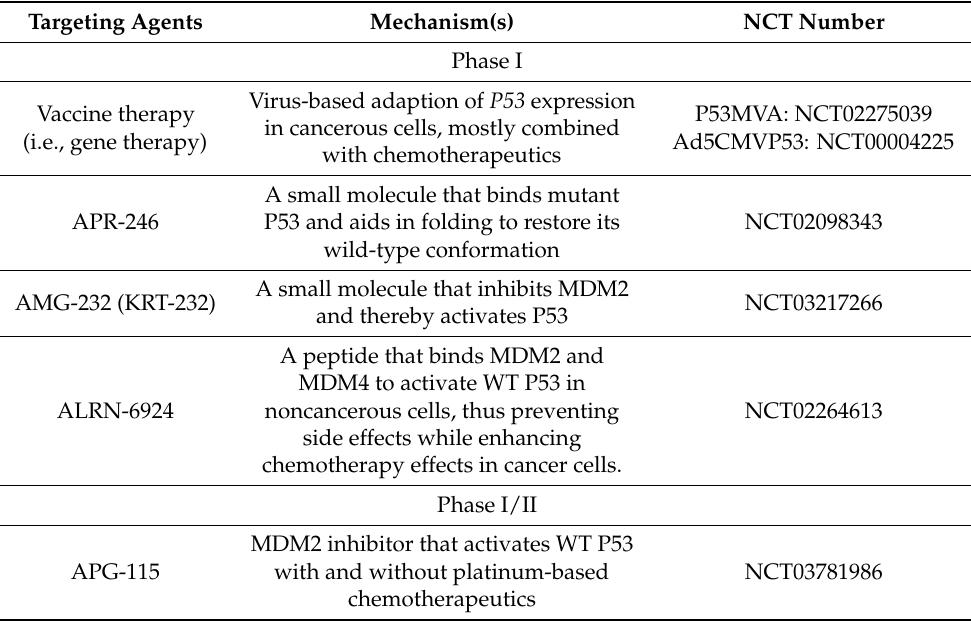
Table 1. Ongoing clinical trials regarding novel targeting agents that modulate the P53